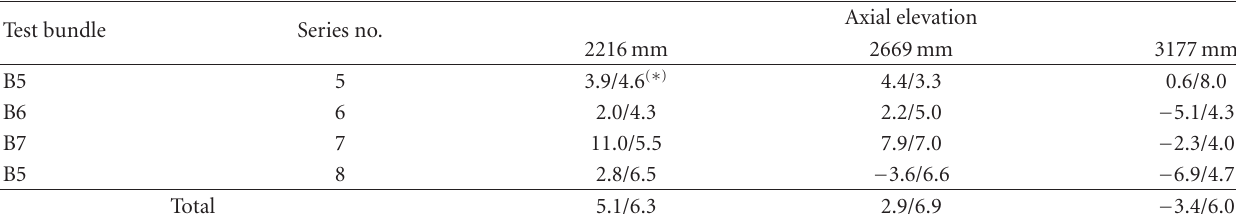
Table 3: Statistics of void prediction error for steady-state void distribution exercises.